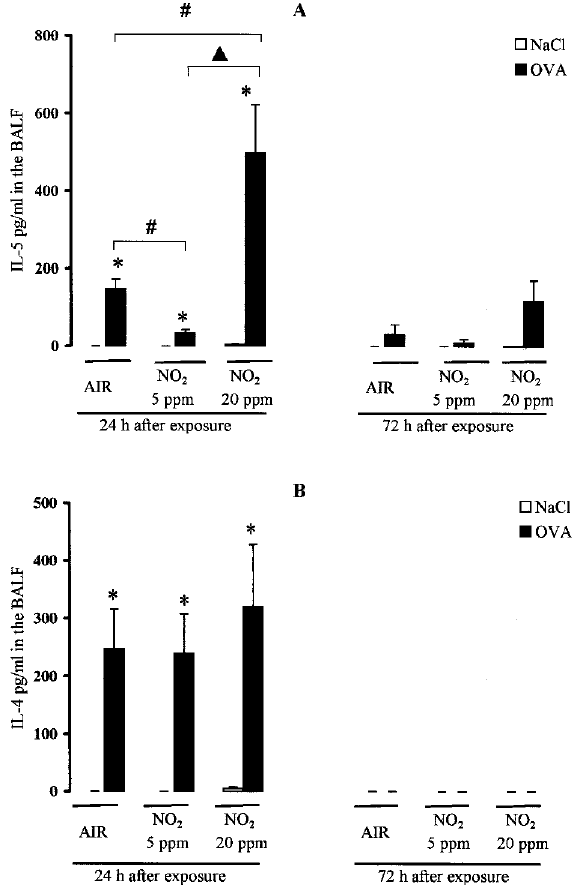
FIG. 4. BALF Th2 cytokine levels after exposures to NO 2 . At day 14, immunized mice were treated as in Fig. 2 (saline ( h ) or OVA ( j )). Specific antibodies were evaluated in the serum by ELISA. BALF IL-4 and IL-5 content were evaluated by ELISA. (A) IL-5 and (B) IL-4. Data are expressed as the mean ± SEM. * p £ 0.05, OVA-challenged mice compared with their saline control; # p £ 0.05, OVA-air group compared with the NO